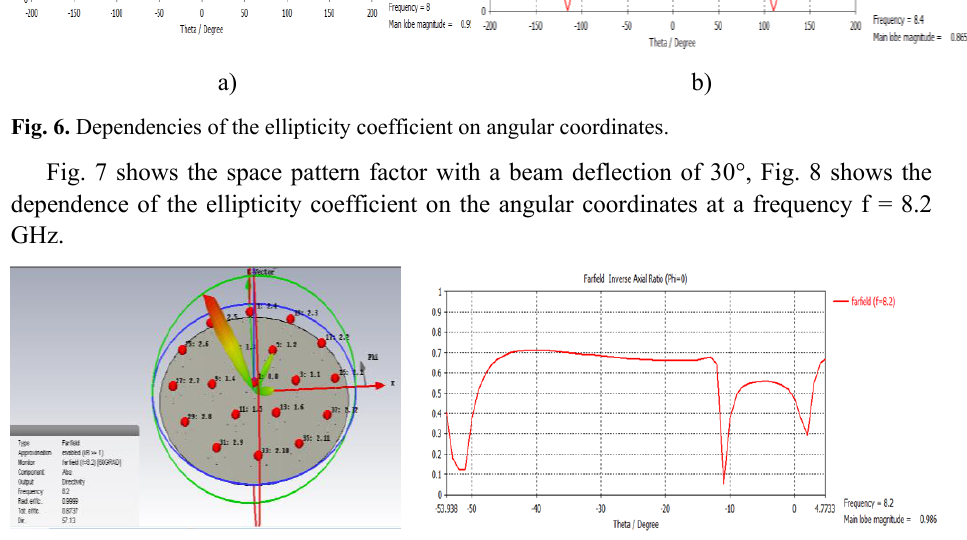
Fig. 7. Space pattern factor with a beam deflection of 30 °.